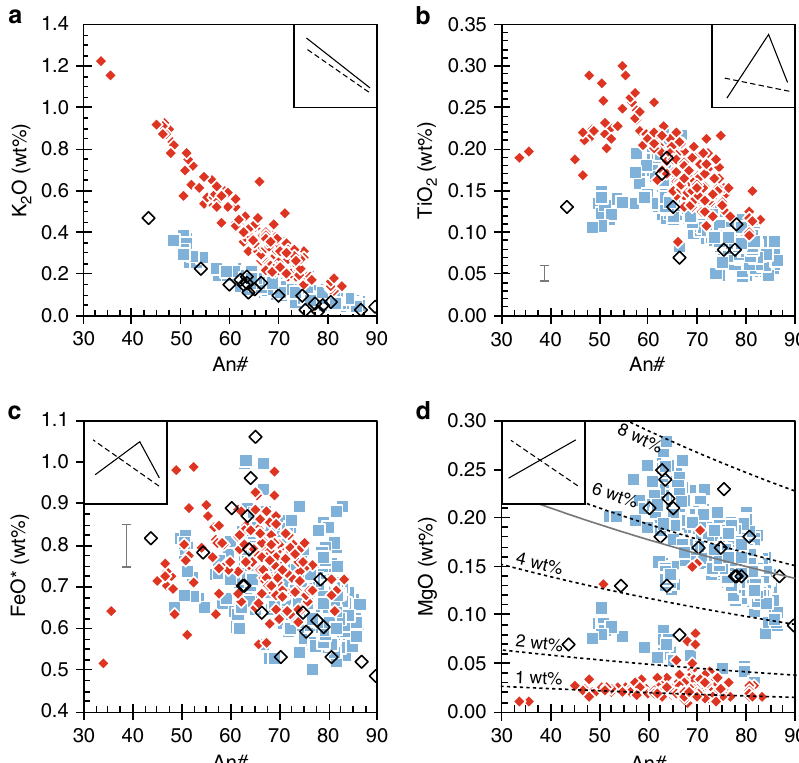
Fig. 5 Plagioclase minor element compositions from Wolf and Fernandina. Minor elements vs. An# of plagioclase crystals in lava and tephra samples from the 2015 Wolf eruption (blue squares), nodule samples from the 1968 Fernandina eruption (red diamonds) and lava samples from historic Fernandina eruptions (open diamonds). Crystal compositions from historic Fernandina lavas are from Allan and Simkin 28 . Characteristic 2 σ analytical uncertainties for our plagioclase analyses are shown or are less than the size of a data point. The lines in ( d ) show the MgO contents of plagioclase crystals calculated to be in equilibrium with liquids containing 1, 2, 4, 6 and 8 wt% MgO (at appropriate temperatures from Wolf Rhyolite-MELTS models at 300 MPa; black dashed lines) and with the average 2015 Wolf tephra glass at 1160 °C (the approximate pre-eruptive crystallisation temperature; solid grey line) 19 , using the MgO partitioning model of Nielsen et al. 43 . Insets show the general theoretical trends of crystal compositions during growth (i.e. fractional crystallisation; solid lines) and diffusive re-equilibration (dashed lines), after Humphreys 39